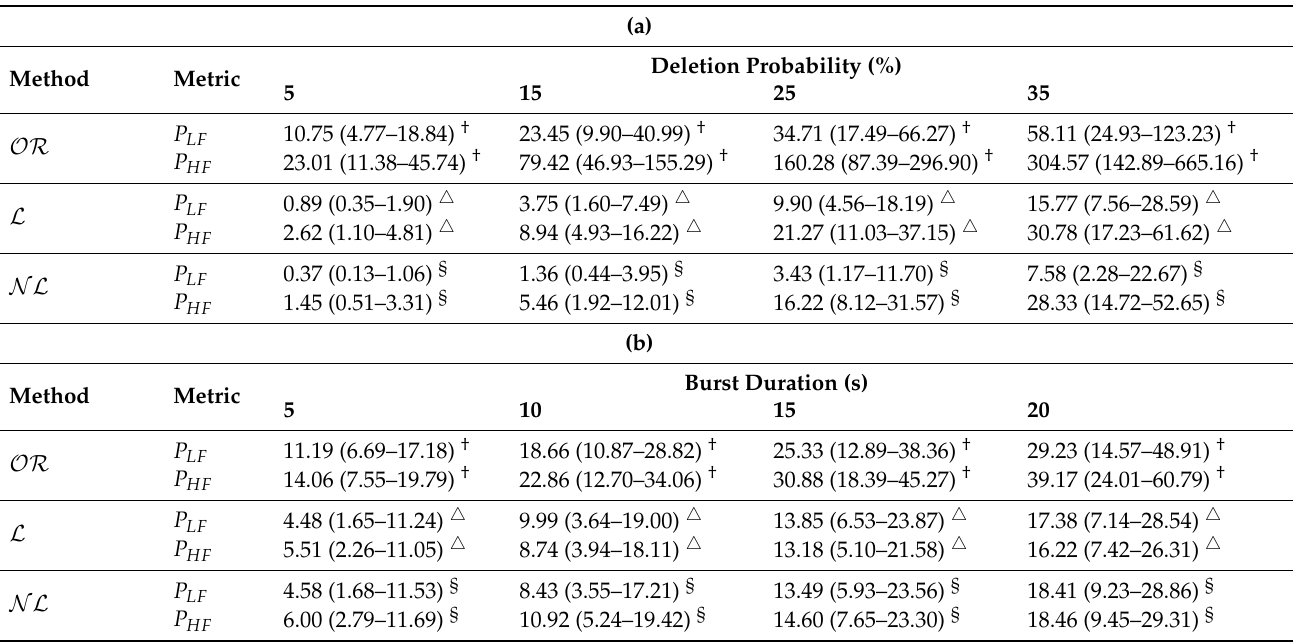
Table 7. Relative error (%) of frequency-domain metrics computed via Lomb’s method. (a) Scat- tered missing beats. (b) Bursts. †: Significant differences ( p < 0.05) between OR and L . (cid:52) : Significant differences ( p < 0.05) between L and N L . §: Significant differences ( p < 0.05) between N L and OR .